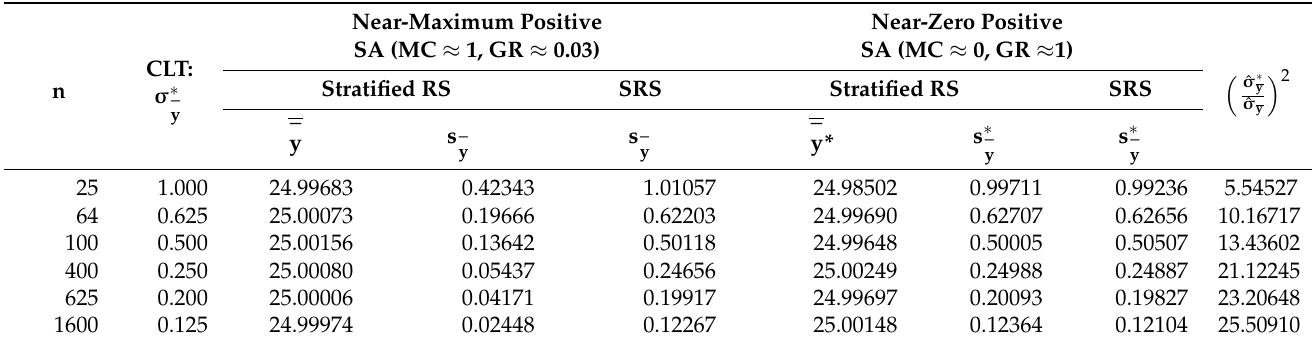
Table 4. Sampling design comparisons in the presence of SA: a specimen 200-by-200 regular